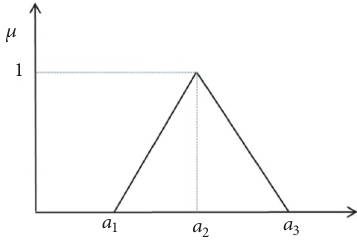
Figure 4: Triangular fuzzy